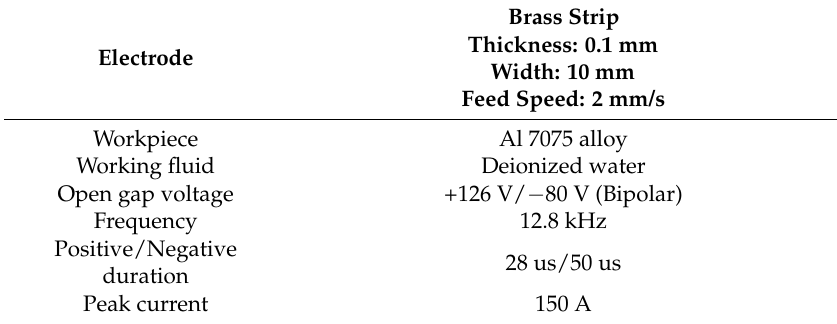
Table 2. Parameters of the commercial wire electrical discharge machining (WEDM) system.